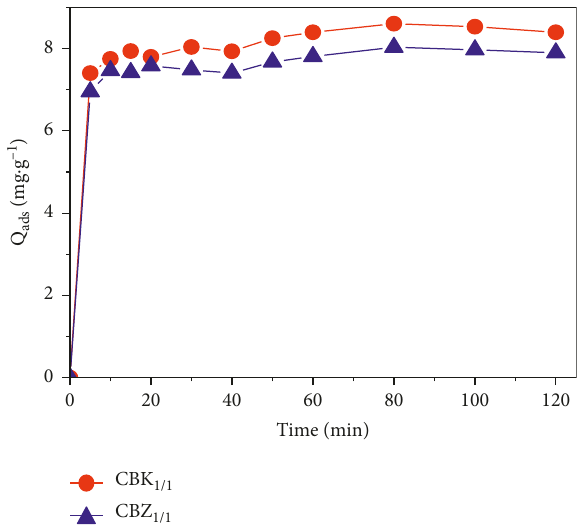
Figure 8: Effect of contact time on the adsorption of indigo carmine. Experimental conditions: C 0 � 50mg · L − 1 ; m � 100mg; V � 20mL; pH � 2; speed � 200rpm at room